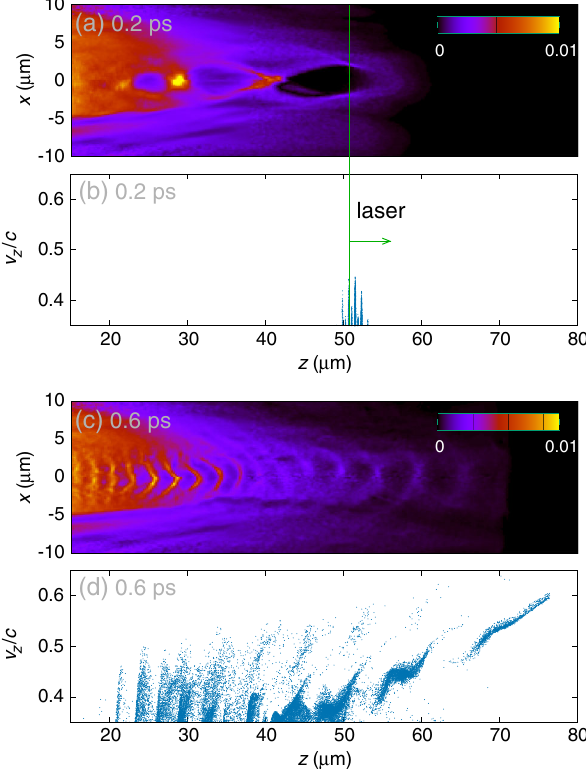
FIG. 4. Results of 3D PIC simulations with reconstructed laser wave front. Electron density n e =n c in the downward density ramp at the exit of the gas jet at (a) 0.2 and (c) 0.6 ps. (b), (d) Corresponding electron longitudinal phase space showing electron trapping and acceleration in the